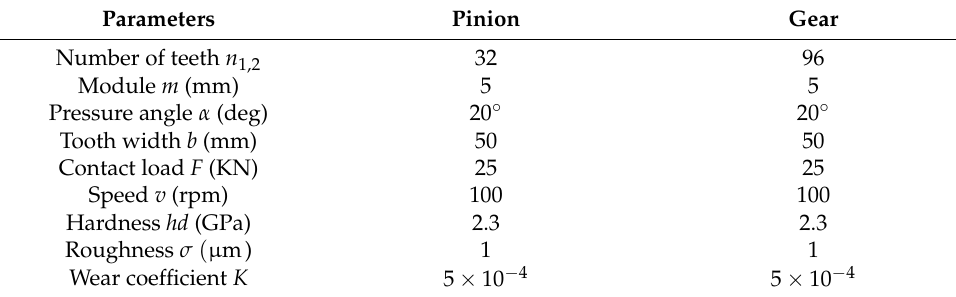
Table 3. Main parameters required for the Kriging model.